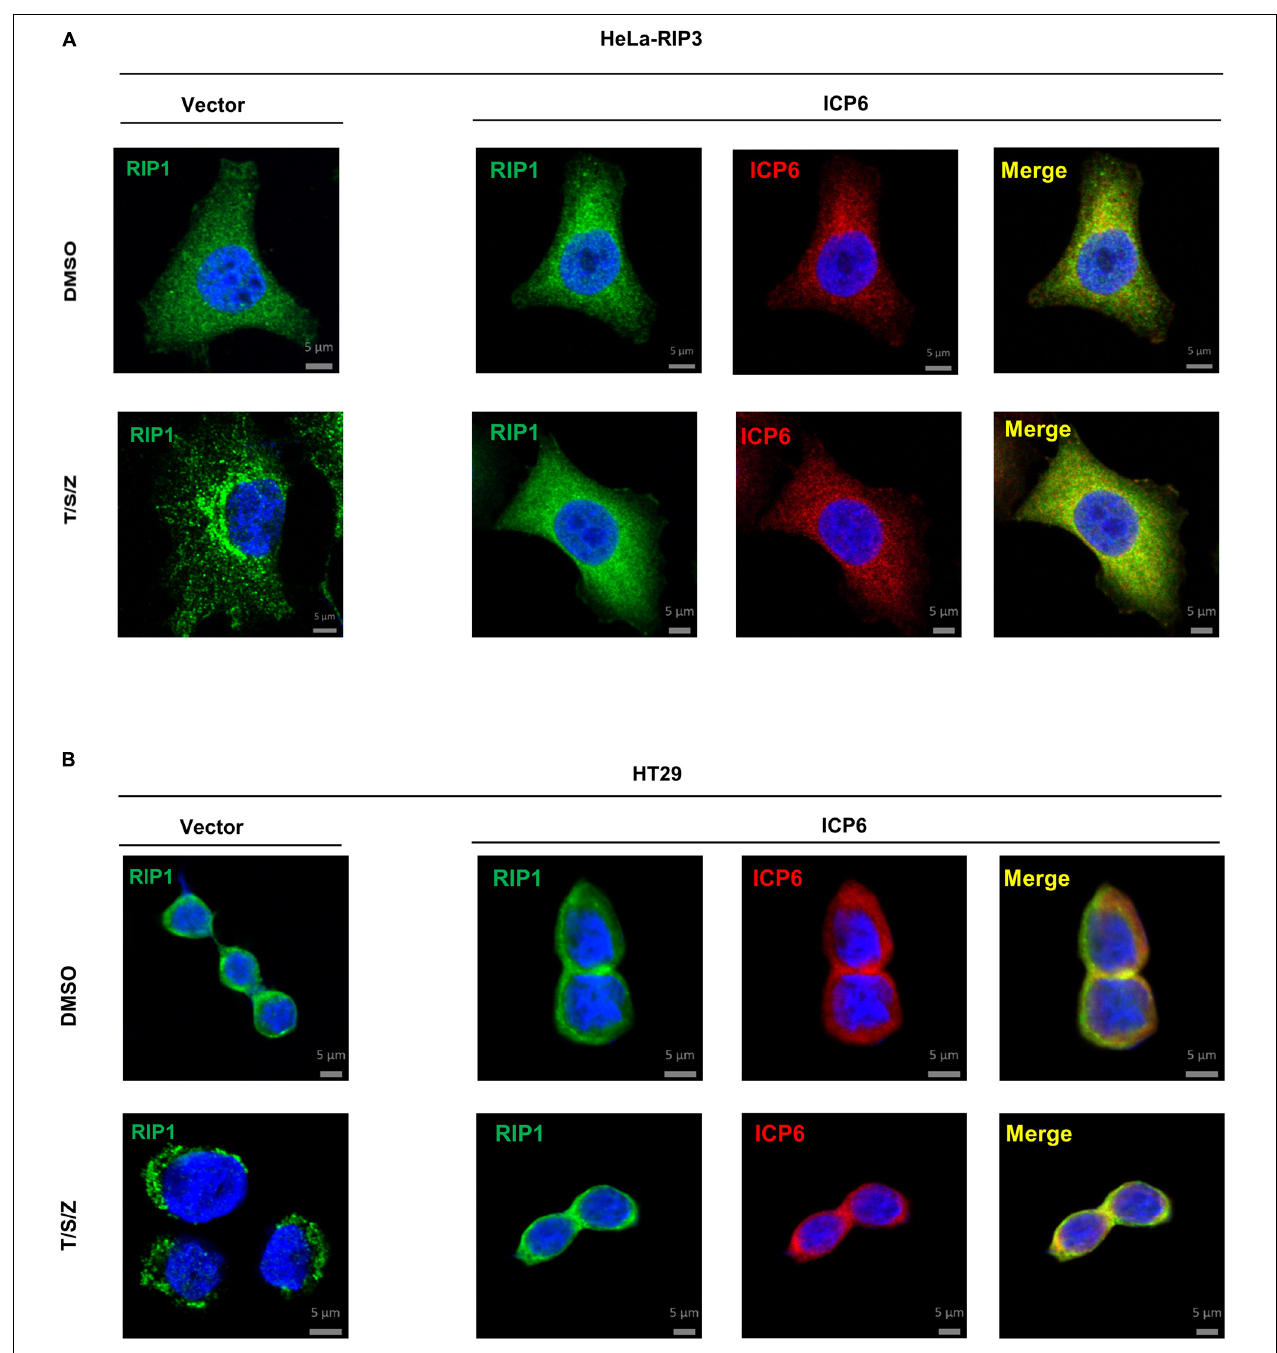
FIGURE 4 | ICP6 inhibits the formation of RIP1 puncta. (A,B) HeLa-RIP3 and HT29 cells infected with empty virus (Vector) or lentiviral virus encoding ICP6 were stimulated as indicated for 6 h, and then immunostained for RIP1, ICP6, and counterstained with DAPI. The distribution of RIP1 (Alexa Fluor 555 dye, green) and ICP6 (Alexa Fluor 647 dye, red) were detected by immunofluorescence as described in “Materials and Methods”. The scale bar represents 5 µ